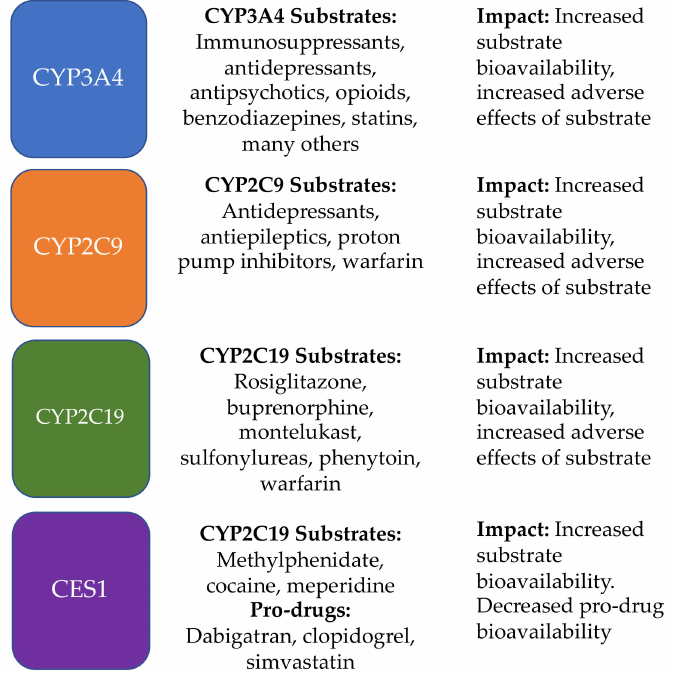
Figure 2. Enzyme targets and example medications that could be a ff ected by THC if